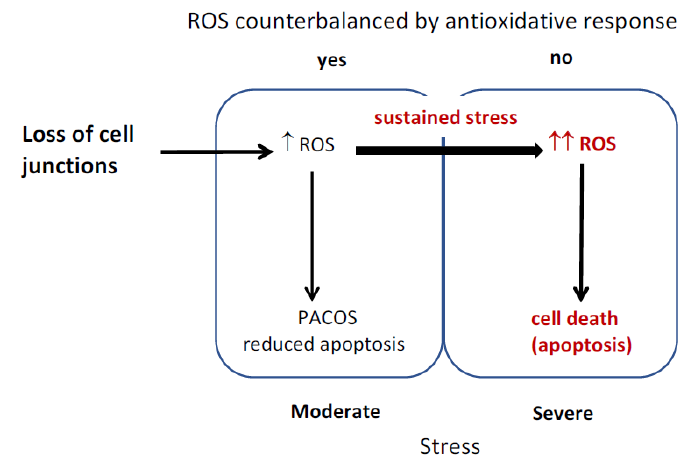
Figure 5. Reactive oxygen species (ROS) induction of stress responses and cell